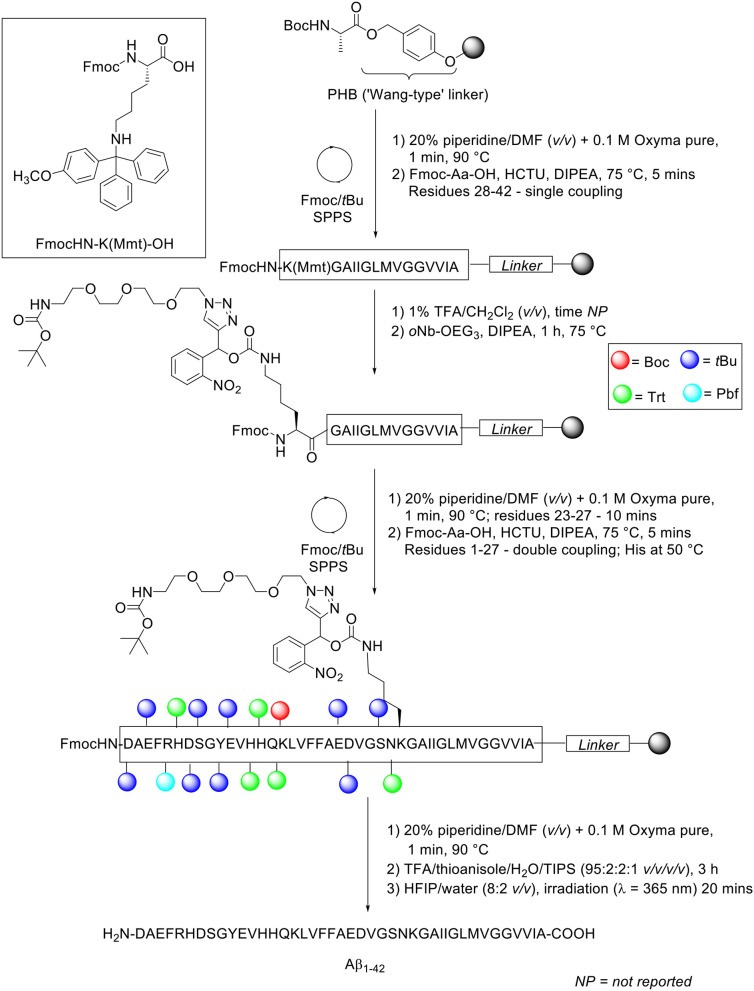
Fmoc/tBu SPPS of Aβ1−42 with oNb-OEG3 tag functionalized on Lys28 residue by Karas et al. (2017).